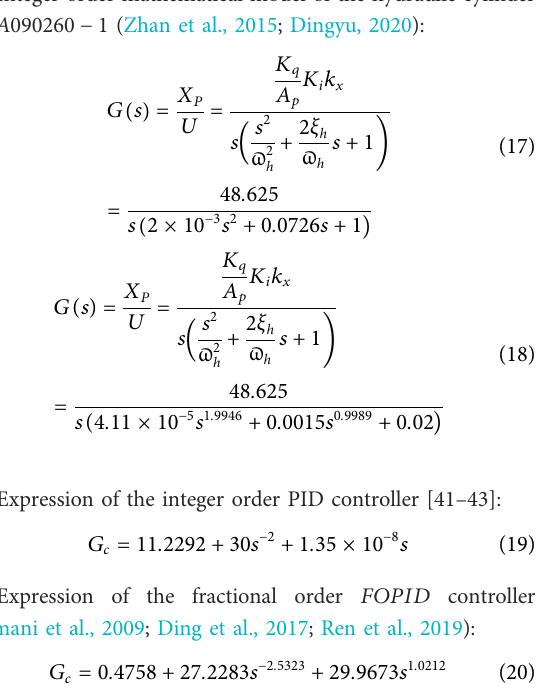
Figure 15 and Table 7 show that the FOPID controller has a better control effect for fractional controlled objects, and the overshoot can reach 6.84% in 0.5s. On the whole, the FOPID controller is more stable than the PID controller, and the PID control strategy shows almost the same control effect, which is about 20%. In the actual support work of the manipulator, if there